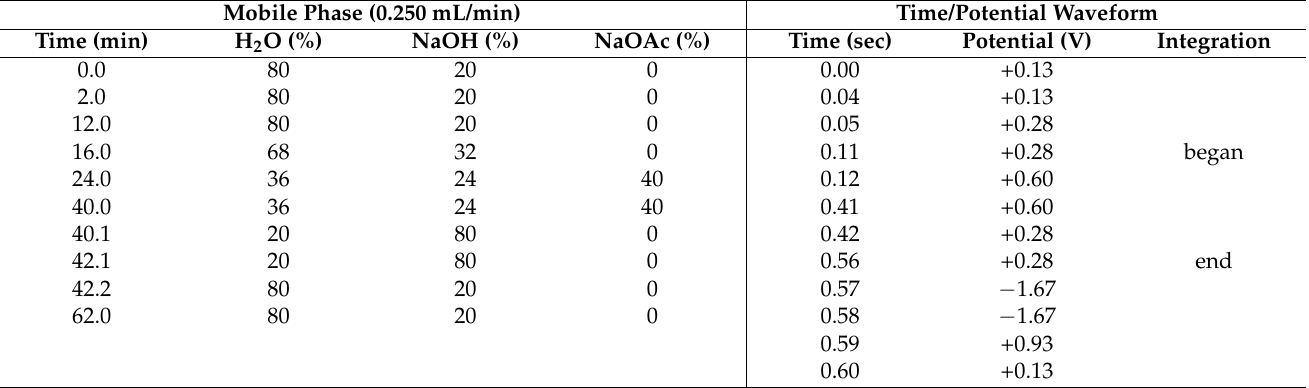
Table 1. Mobile phase and time/potential waveform used for amino acids